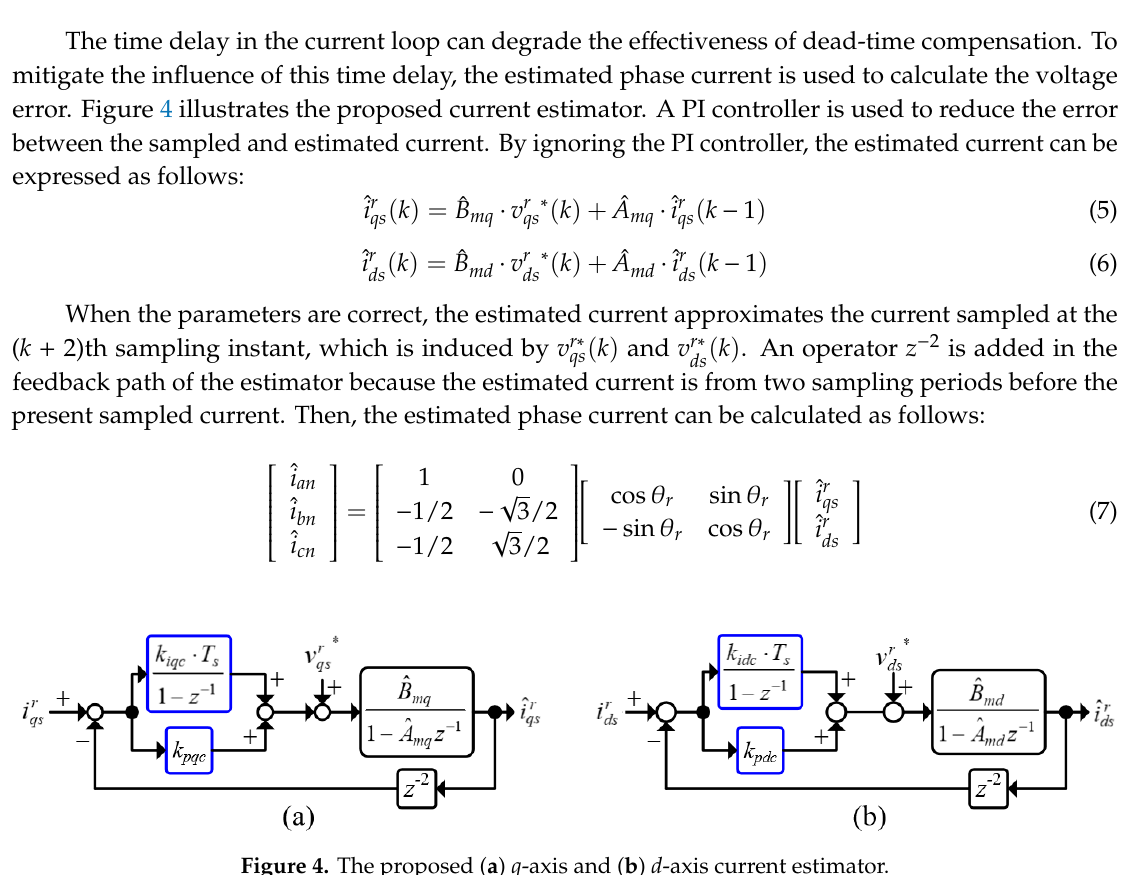
Figure 3. The voltage error caused by the dead-time at different phase current.